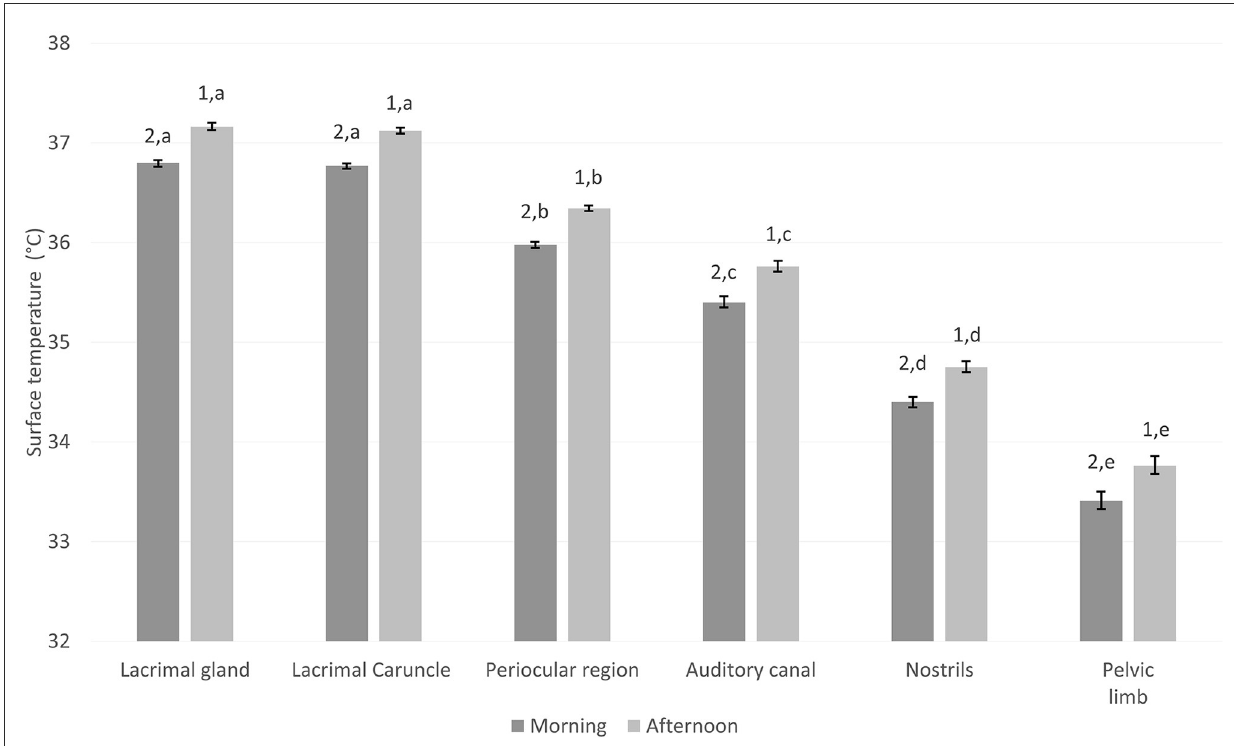
FIGURE2 Mean surface temperature ± standard error (SE) of six thermal windows of water buffalo neonates ( n = 109) at two different times of day (morning from 8:00 to 9:00a.m., afternoon from 15:00 to 16:00 p.m.). Linear mixed model analysis with a Tuckey post-hoc test using the GraphPad program (VER. 9.4.0). n , number of calves; Weight of calves according to category: Q 1 , 37.8–41.25kg; Q 2 , 41.3–46.3kg; Q 3 , 46.4–56.3kg; Q 4 , 56.4–60.3kg. Mean ± standard error. A significance level of p < 0.05 was established. a,b,c,d,e Different literals indicate a statistical difference between the weights of the animals. 1,2 Different numbers indicate statistically significant differences between days in the same weight